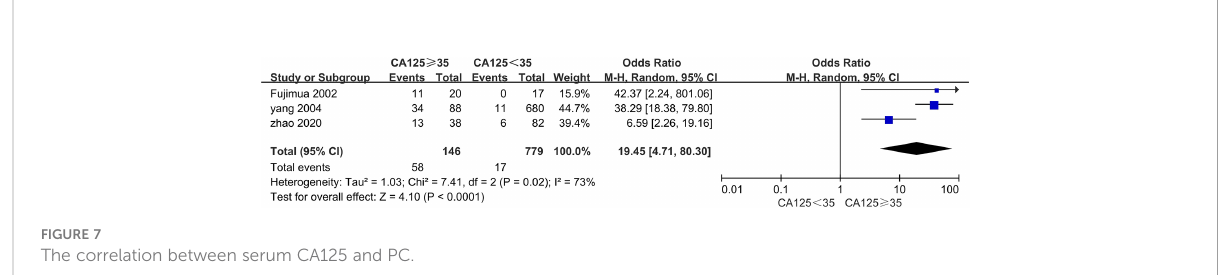
FIGURE 7 The correlation between serum CA125 and